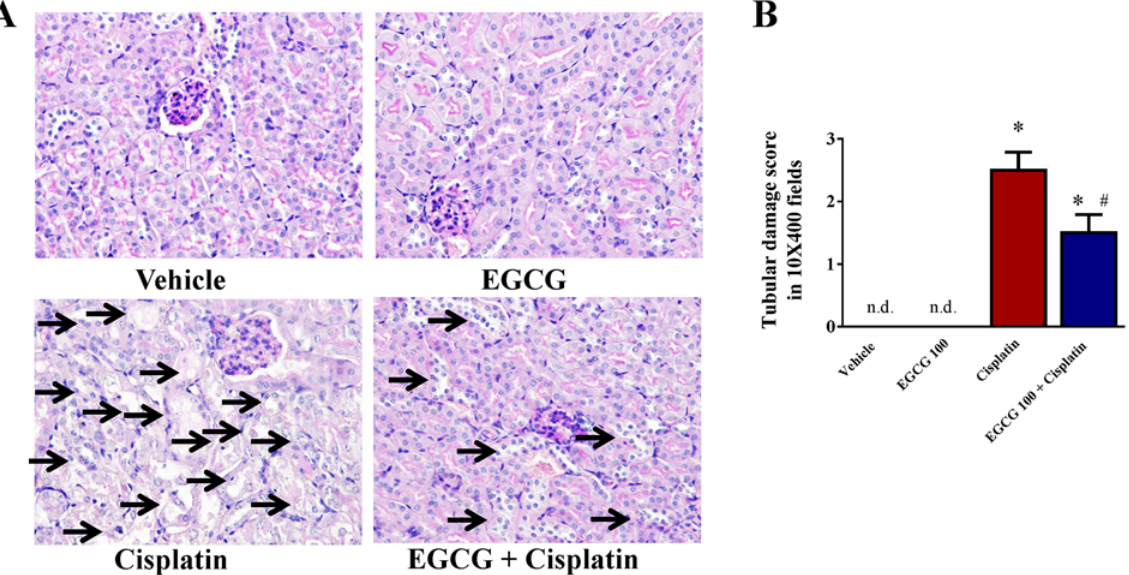
Fig 2. Effect of EGCG on cisplatin-induced kidney tubular damage in mice. Cisplatin administration resulted in severe tubular damage as shown by histological examination using PAS staining. The damage was attenuated by EGCG treatment at dose 100mg/kg (designated as EGCG 100). Results are mean ± S.E.M., n = 4/group. * p < 0.05 versus vehicle; and # p < 0.05 versus cisplatin.